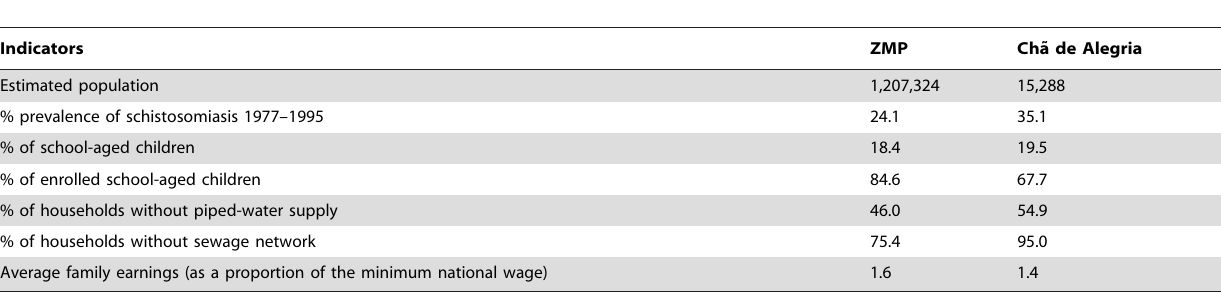
Table 1. Historical prevalence of schistosomiasis and demographic and socio-economic indicators estimated for 2006 in the